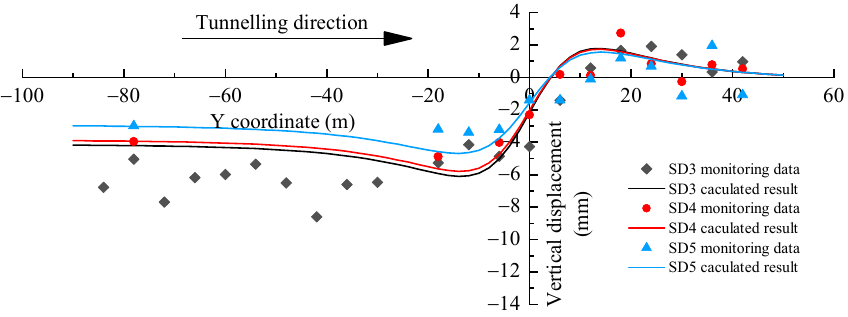
Figure 14. Comparison of predicted and measured longitudinal ground displacement in case A. The comparison of predicted and monitored ground surface displacement in case B was obtained using the same superposition method as in case A, as shown in Figure 15. It can be seen that the comparison results show a good agreement. The ground surface